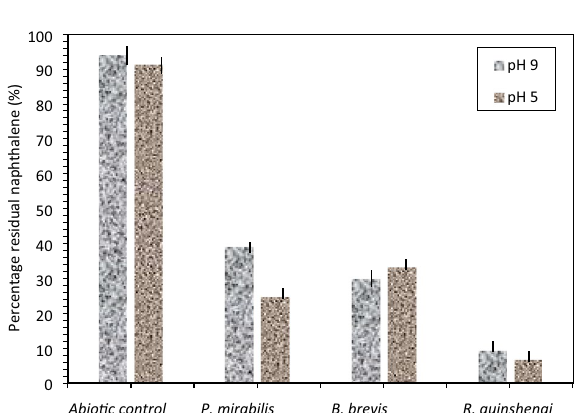
Table 3. Levels of unmetabolized naphthalene (ppm) in bacterial cultures at day 18 with varying pH. SD standard deviation.